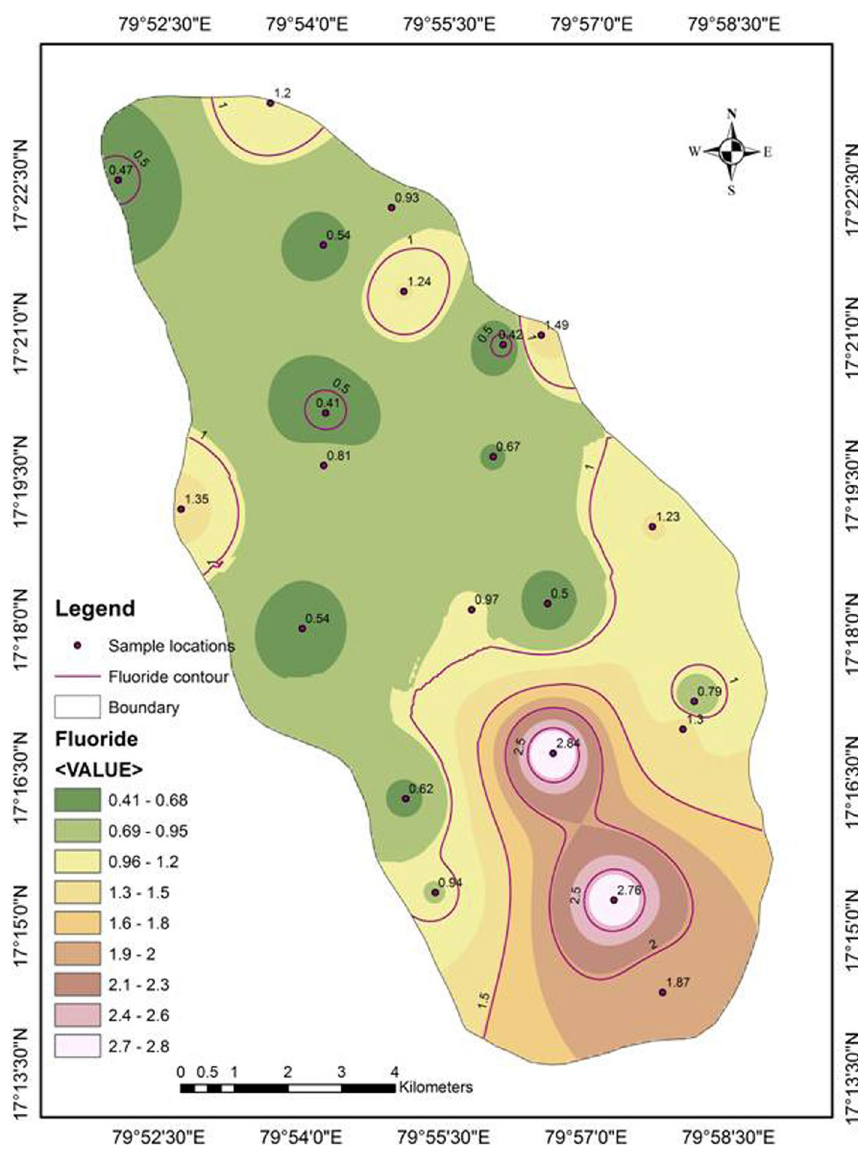
Fig. 6 Fluoride distribution in the Subledu